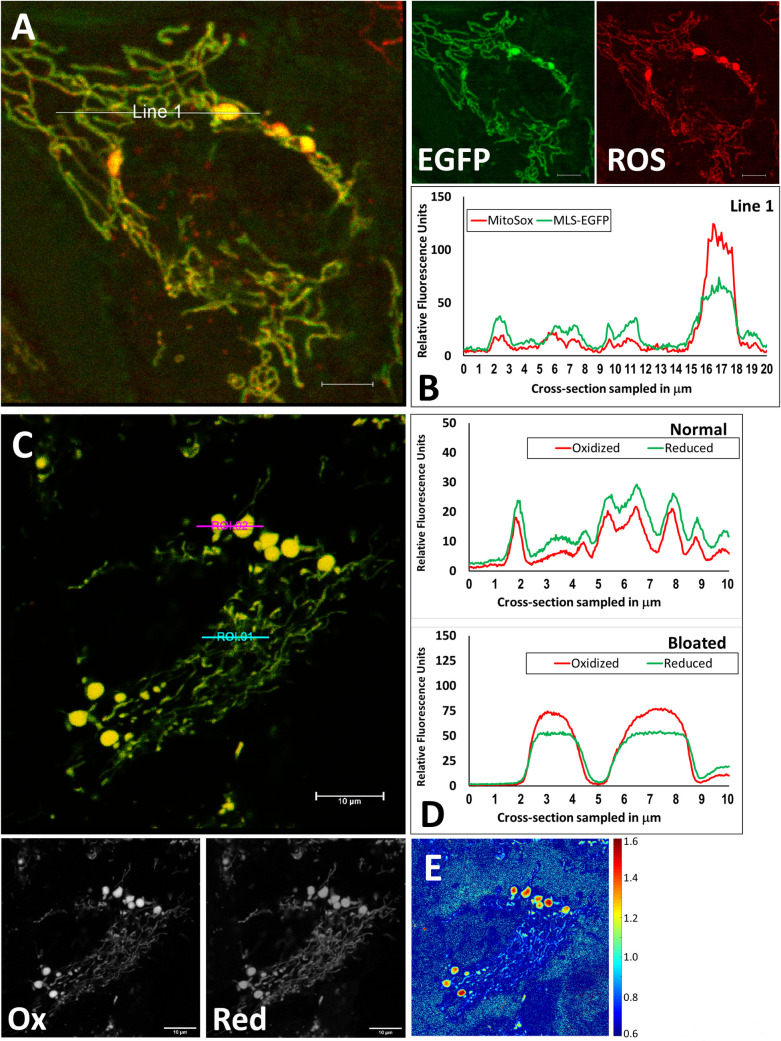
Swollen mitochondria exhibit a more oxidative enviroment than mitochondria with normal morphology.A. Representative confocal image of the ROS signal generated by MitoSOX (red) accumulating in A549 cells expressing MLS-EGFP (green). Scale bars are 5 μm. Leica SP8, 63x, 5% CO2, 37⁰C, 95% relative humidity, operating in photon-counting mode. B. Trace derived from “Line-1” in A that intersects both normal and bloated mitochondria. Line is 20 μm and traces extend from left to right. C. Confocal image representing the oxidation state of mito-roGFP in A549 cells. The 525 nm emission intensity signals induced by 405 nm or 488 nm excitation, represent oxidized and reduced protein, respectively, are superimposed in the main panel and resolved individually in panels directly below. Scale bars are 10 μm. Leica SP8, 63x, 5% CO2, 37⁰C, 95% relative humidity, operating in photon-counting mode. D. Linear traces show the 525 nm fluorescence intensities for the oxidized (red) and reduced (green) forms of mito-roGFP2 in ROIs 1 and 2 of panel C bisecting normal and bloated mitochondria, respectively. E. Two-dimensional heatmap of the oxidized:reduced ratio of mito-roGFP.